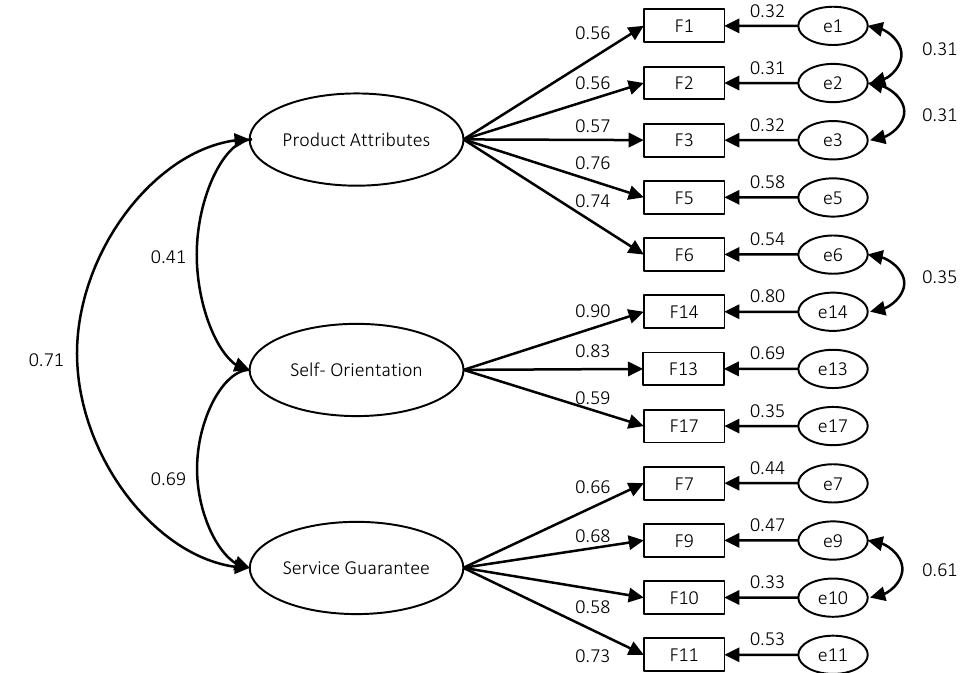
Figure 1. Involving purchase motives in